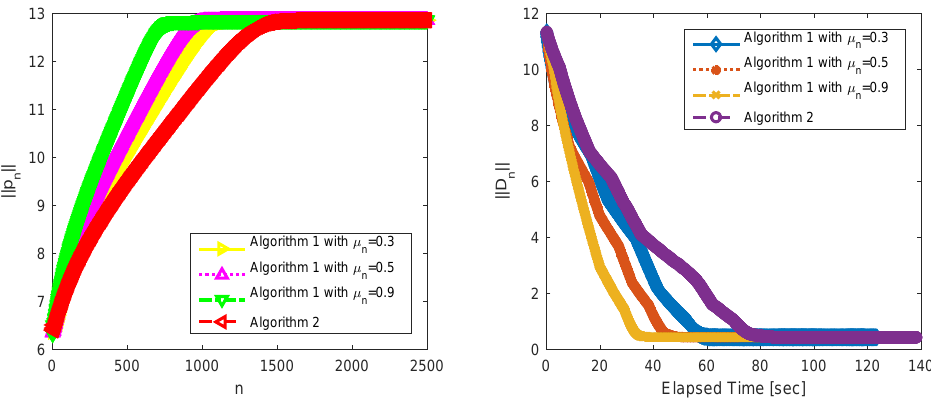
Figure 3. The behavior of (cid:107) p n (cid:107) with the number of iterations (left), the behavior of (cid:107) D n (cid:107) with the running time (right). The number of iterations is 2000. The first CPU time to compute (cid:107) p 2000 (cid:107) is about 123.41 s; the second CPU time to compute (cid:107) p 2000 (cid:107) is about 116.64 s; the third CPU time to compute (cid:107) p (cid:107) is about 116.59 s; the fourth CPU time to compute (cid:107) p 2000 in